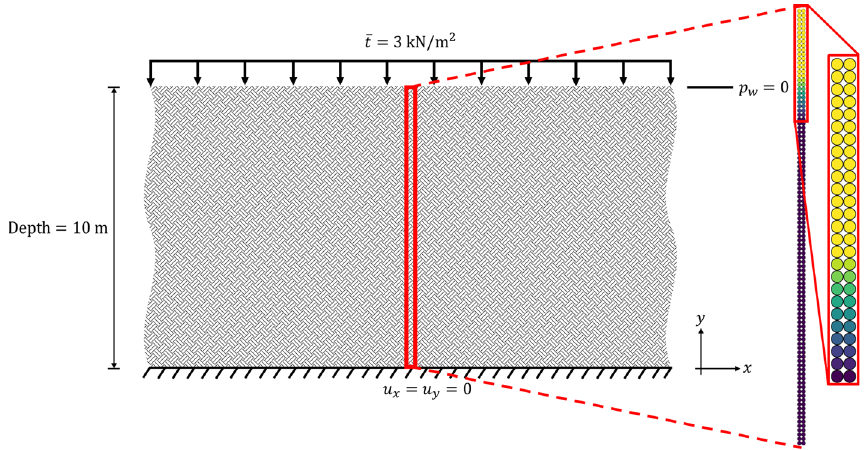
Fig. 10 Base ramping function r ( y ) for the two L–SL cases: the yellow and dark purple colors denote r = 1 and r = 0 , respectively. r linearly changes in space